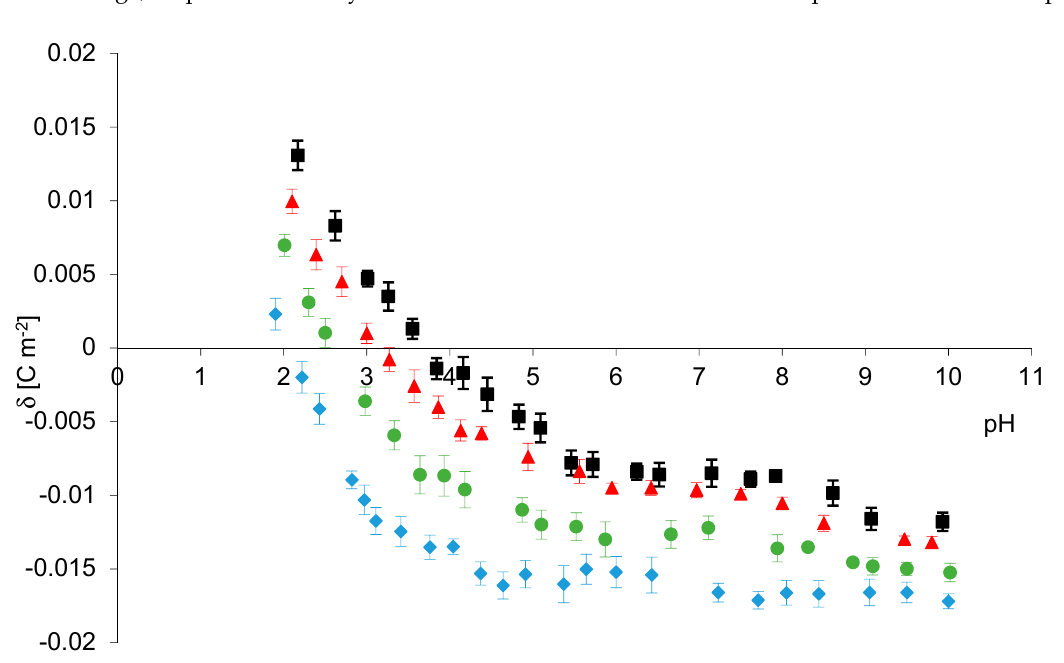
Figure 1. Experimental surface charge densities for phosphatidylcholine liposomal membranes as a function of electrolyte pH (155 mM); NaCl (black), NaBr (red), NaNO 3 (green), NaI (blue).